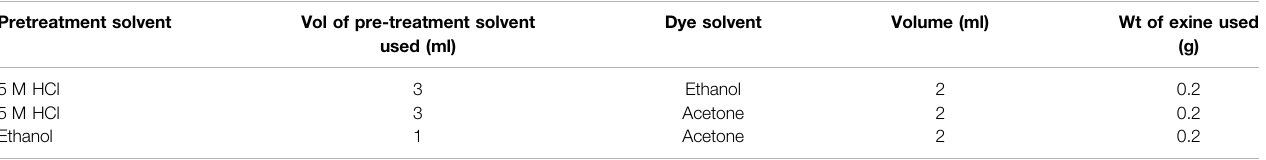
TABLE 1 | Experimental conditions for the adsorption of rhodamine B (rows one and 2) and naphthol blue-black (row 3): pre-treatment solvent, elution solvent ( c. 0.1 g L -1 ), and volume and quantity of exines used in the ‘ column ’ . Pretreatment solvent Vol of pre-treatment solvent used (ml)